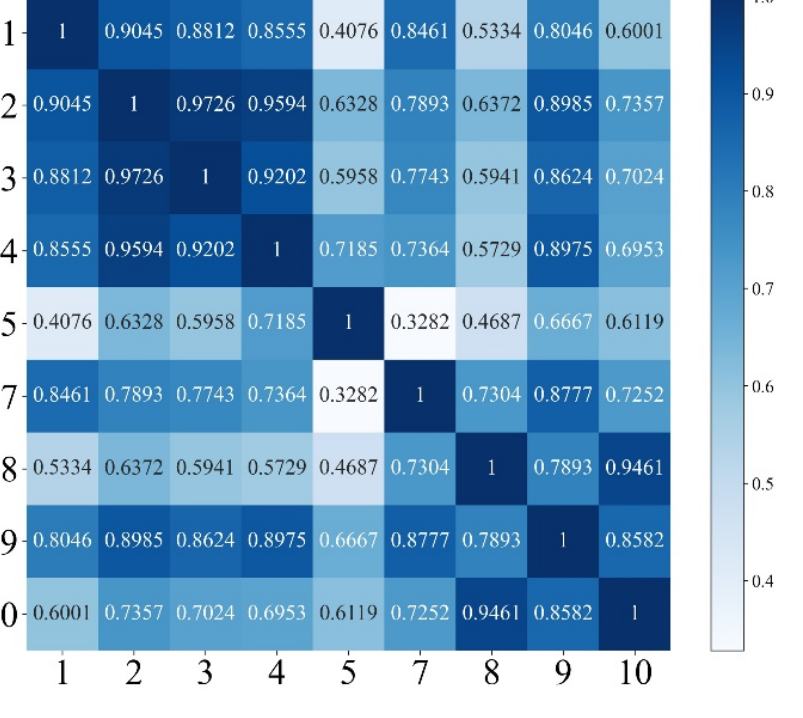
Figure 9. Similarity metric matrix. The horizontal and numerical axes indicate the i-th dormitory building.